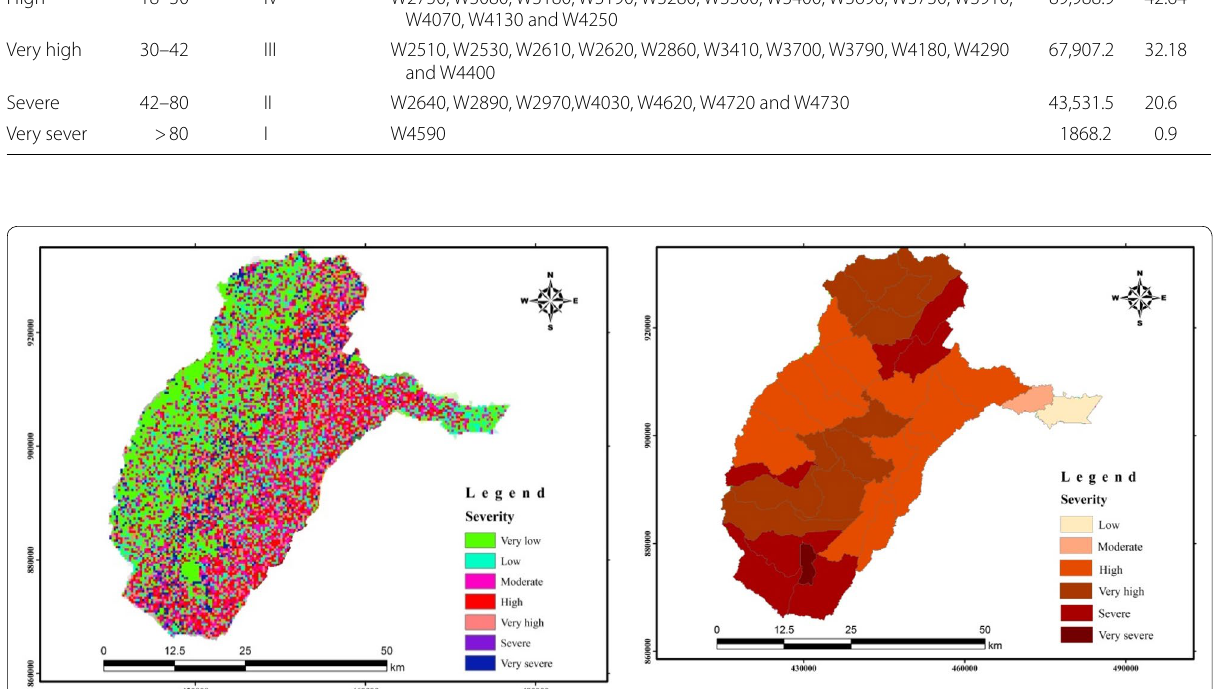
Fig. 21 Spatial distribution of severity and its priority